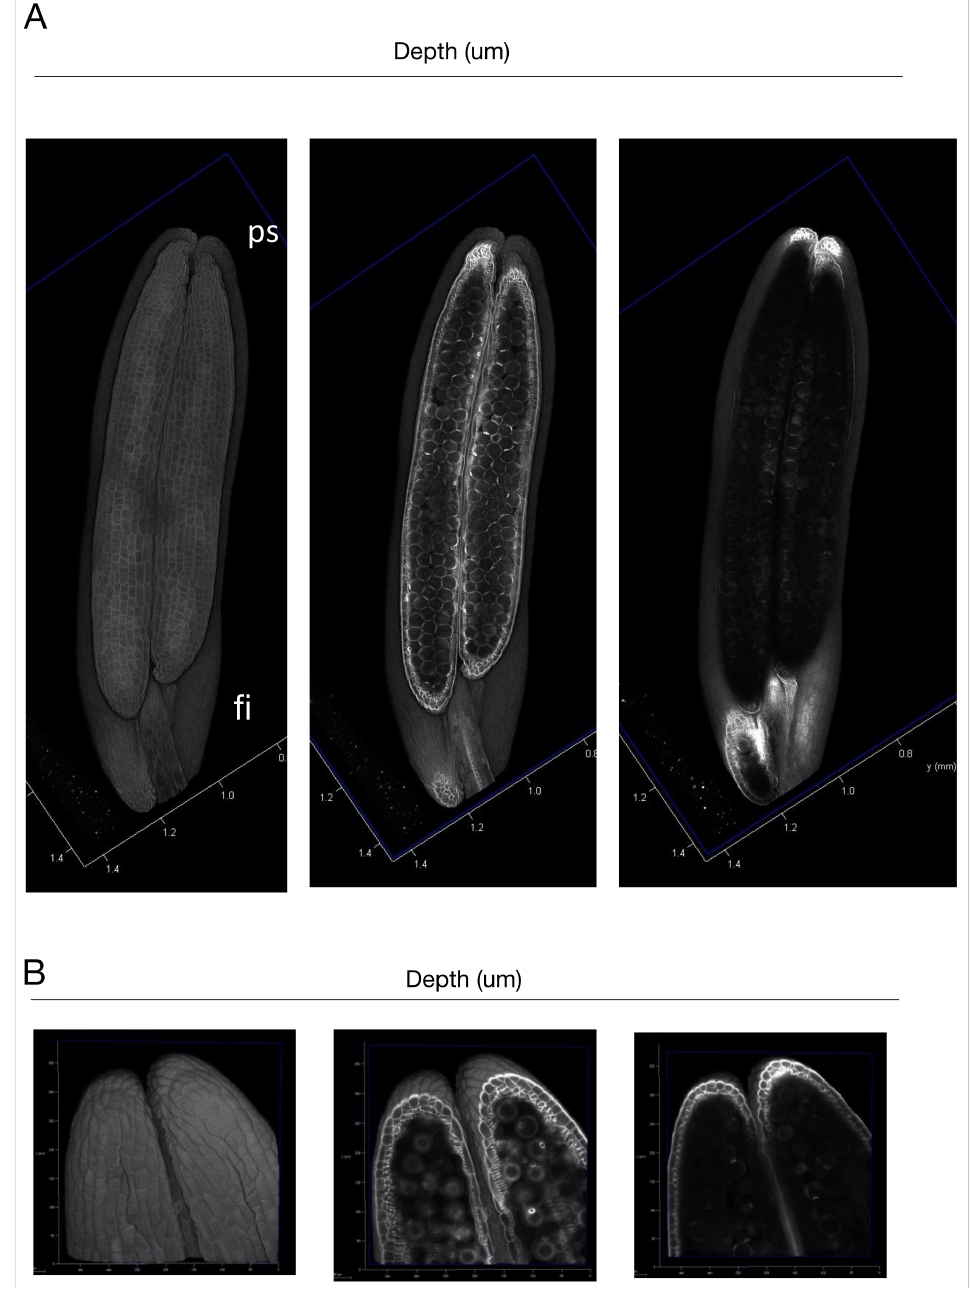
Figure 4. ( A ) Longitudinal sections of the 3D-reconstructed rice anther. ( B ) Longitudinal sec- tions of the 3D-reconstructed rice tip of pollen sacs. ps; pollen sac, fl; filament, pg; pollen grain, gp; germination pore. Bars; 100 µ